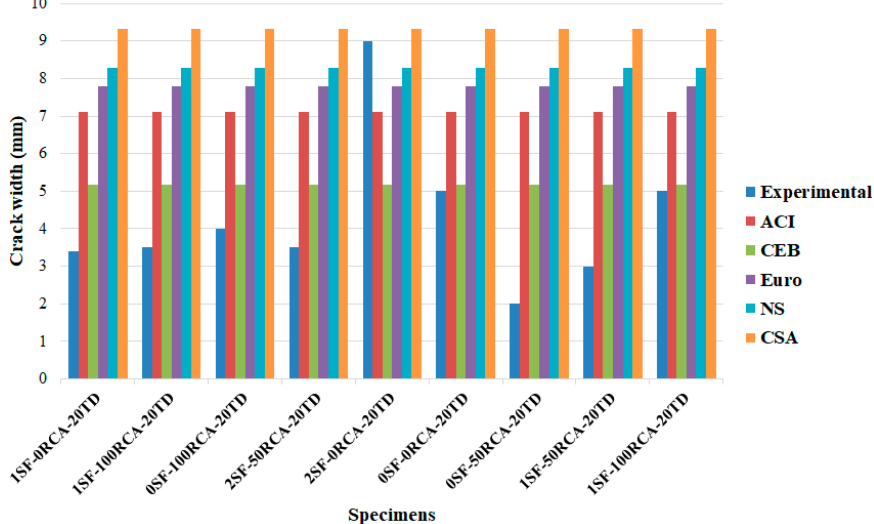
Figure 23. Observed versus predicted ultimate crack widths of specimens with a 200 mm shear rebar spacing.